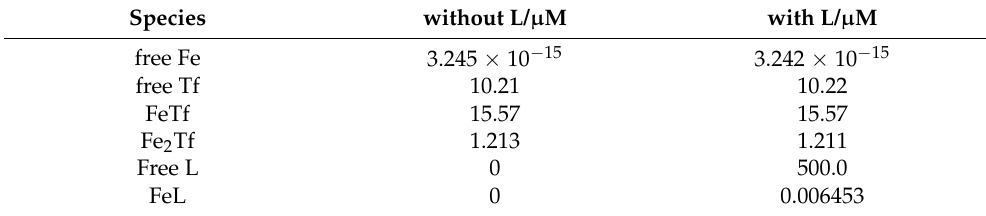
Table 3. Calculated iron coordination species in solution. Total Fe: 18.0 µ M; total Tf: 27.0 µ M; total L: 500 µ